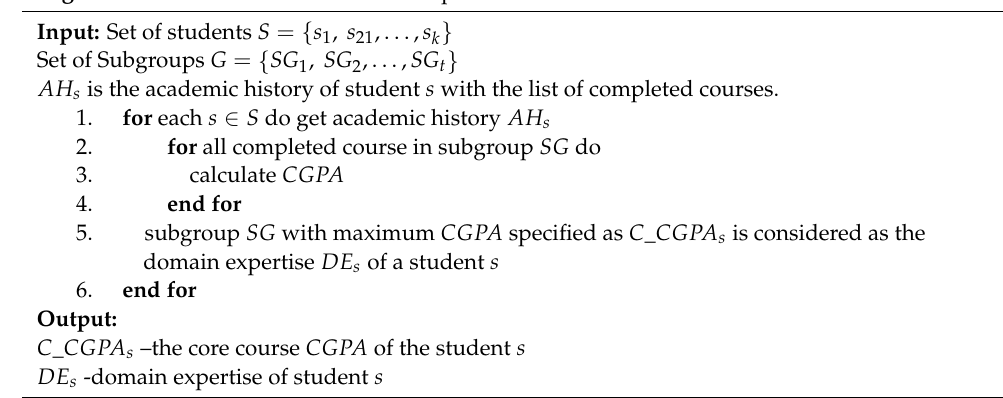
Algorithm 2: Identification of domain expertise of a